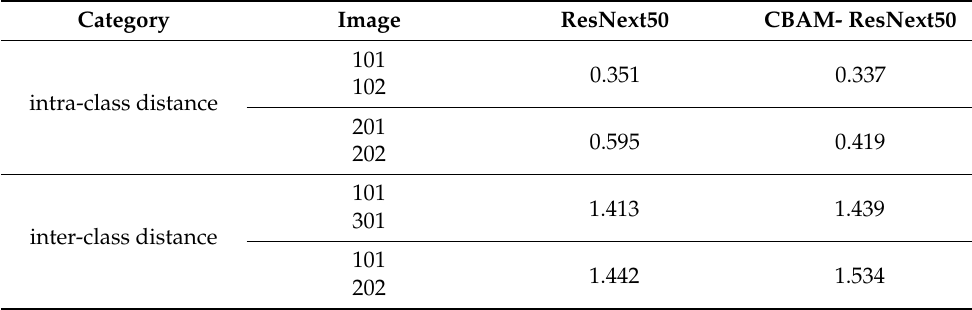
Table 2. Comparison of network performance before and after embedding